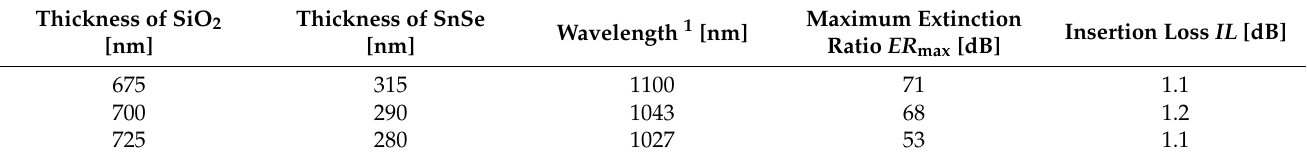
Table A2. Performances of separating p light at specific wavelength with thinner SnSe’s thickness ( d SnSe = 315, 290 and 280 nm) respectively at the SiO 2 ’s thickness of 675, 700, and 725 nm.